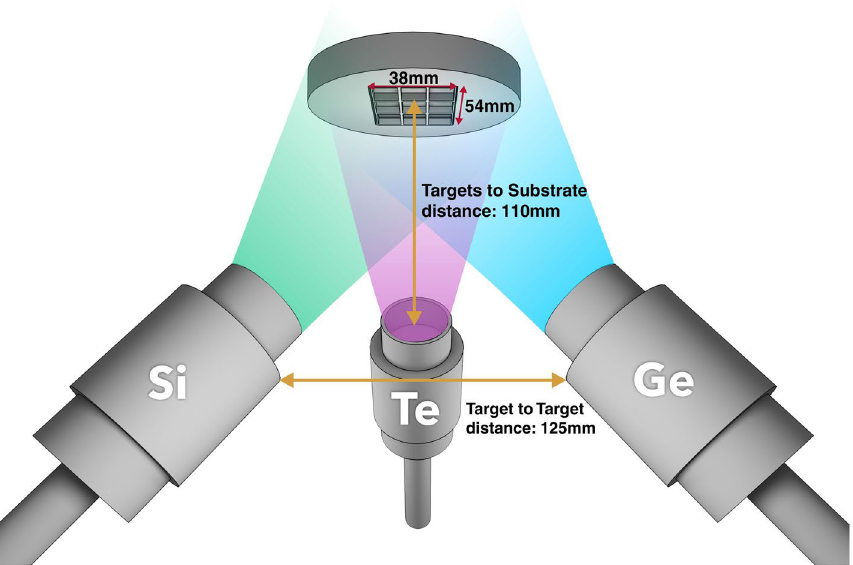
Figure 9. Schematic of the experimental combinatorial deposition setup. The three sputtering targets (Si, Ge and Te) are equidistant (125 mm) and placed at a 45 degree angle with respect to the substrate surface. The substrates are placed in the center of a circular holder above the targets at a distance of 110 mm. The figure was generated using 3ds Max 2020 (https:// www. autod esk. com/) and CorelDRAW 11 (https:// www. corel draw.